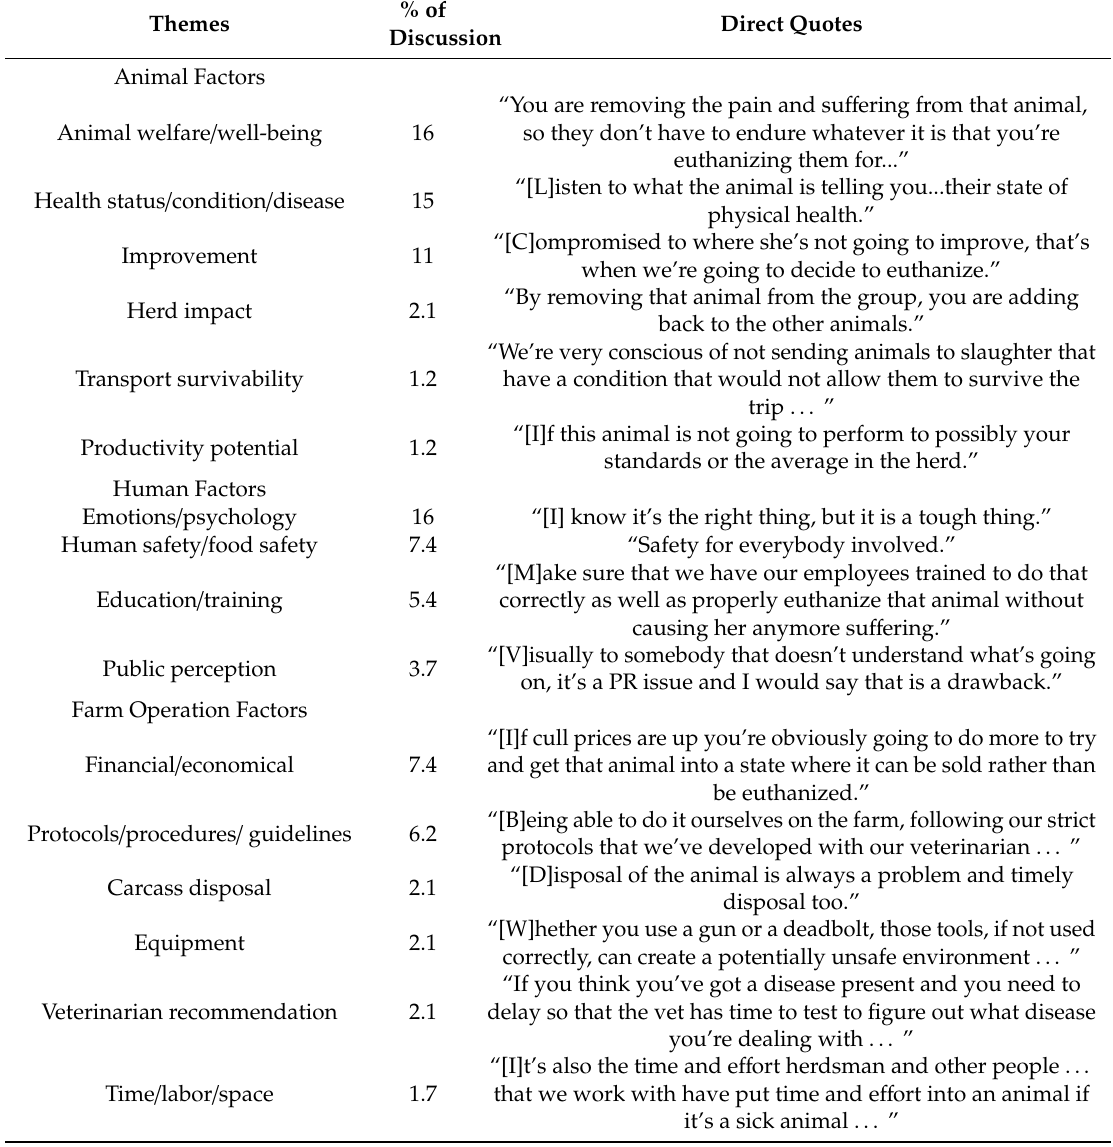
Table 3. Main themes and subthemes discussed by focus group participants, the proportion of time dedicated to each theme and a brief, direct quote that highlights each